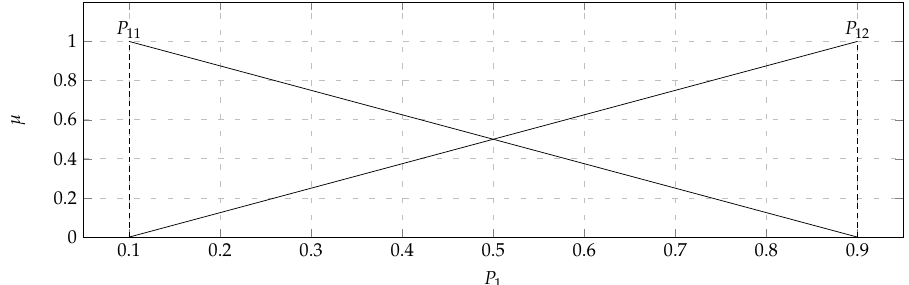
Figure 16. Visualization of Effectiveness per round assessment model ( P 1 ) and triangular fuzzy numbers 0.1 ( P 11 ) and 0.9 ( P 12 ).